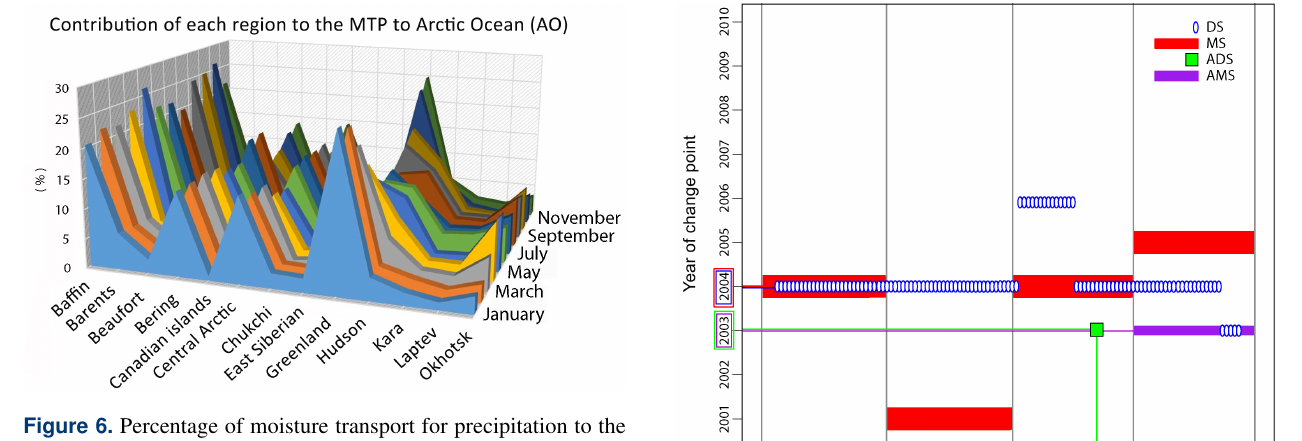
Figure 6. Percentage of moisture transport for precipitation to the whole Arctic Ocean by subregion and month.